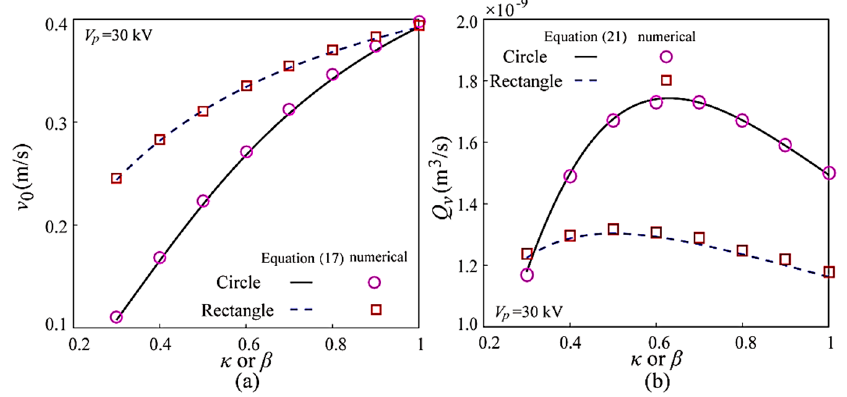
Figure 2. Validations of electroosmotic flow (EOF) velocity in the parent microchannel ( a ) and EOF flowrate ( b ).